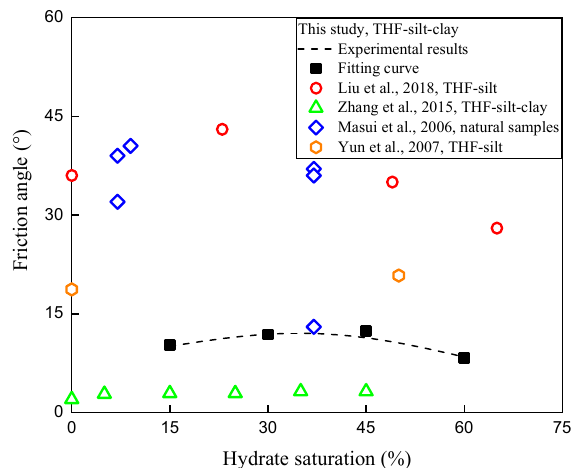
Figure 7. The relationship between the internal friction angle and hydrate saturation (based on [21–23,26]).